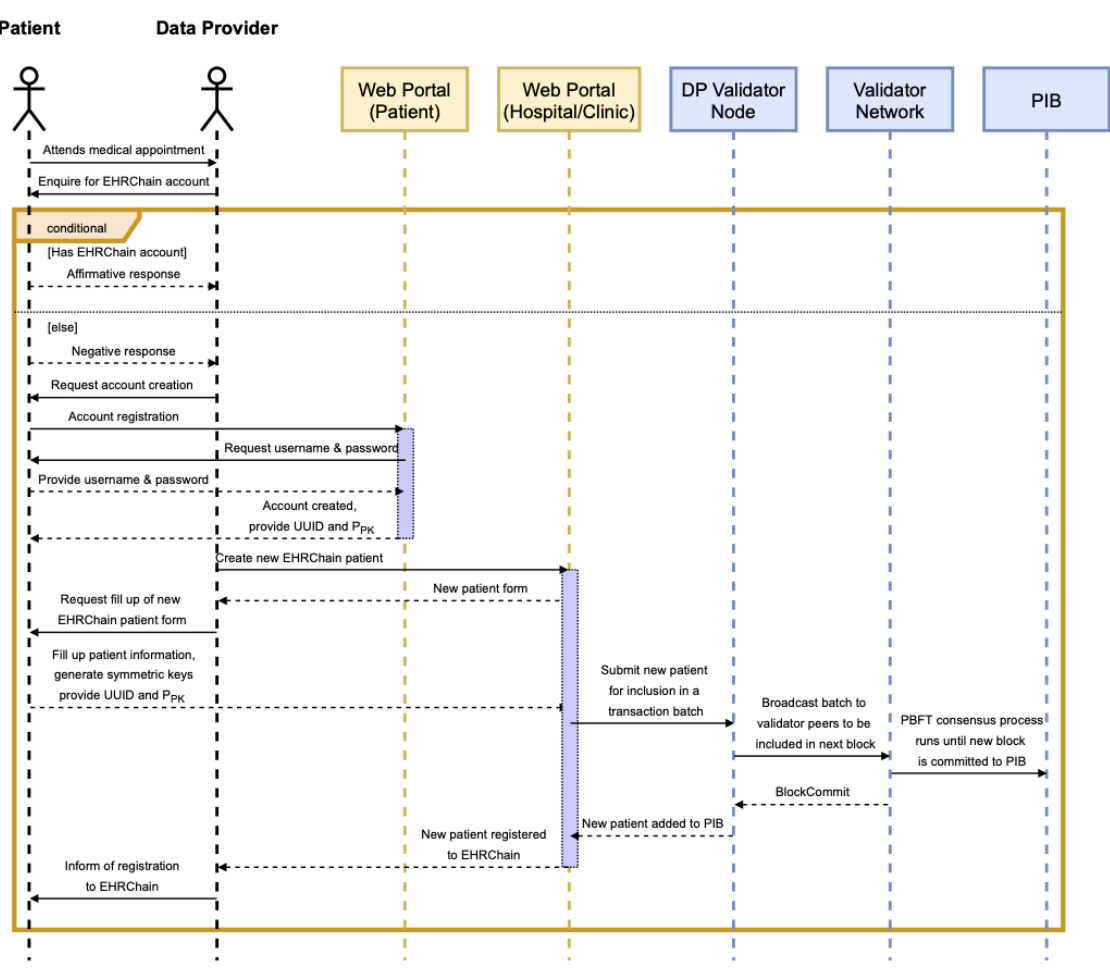
Figure 12. Patient registration sequence diagram.